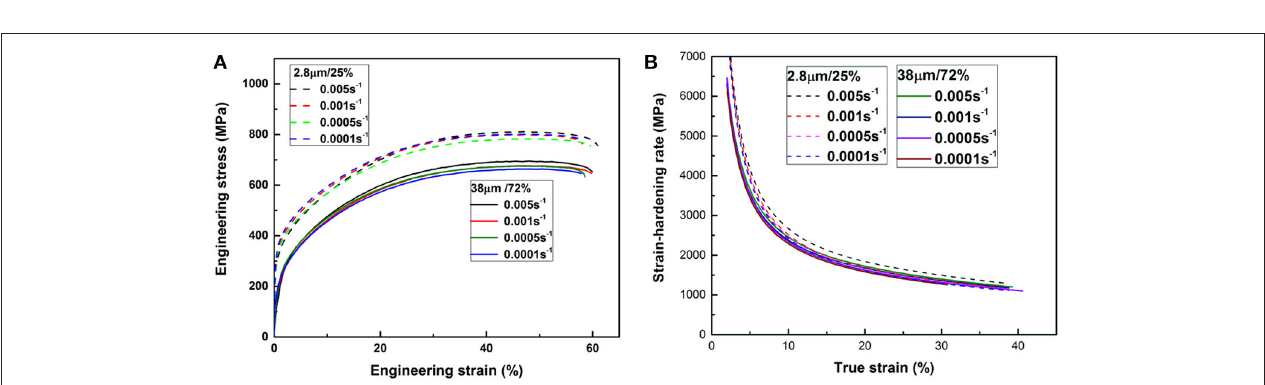
FIGURE 2 | Combined ECCI, EBSD and EDS analysis on the coarse-grained dual-phase HEA prior to deformation: (a) ECC image with relatively low magnification; (b) ECC image of the smaller marked region in (a) showing the martensite laths; (c) EBSD phase and boundary map of the larger marked region in (a) ; (d) EBSD IPF map of the identical region in (c) ; (e) EDS maps of the larger region marked in (a) showing the distribution of the four principal elements, i.e., Fe, Mn, Co, and Cr.